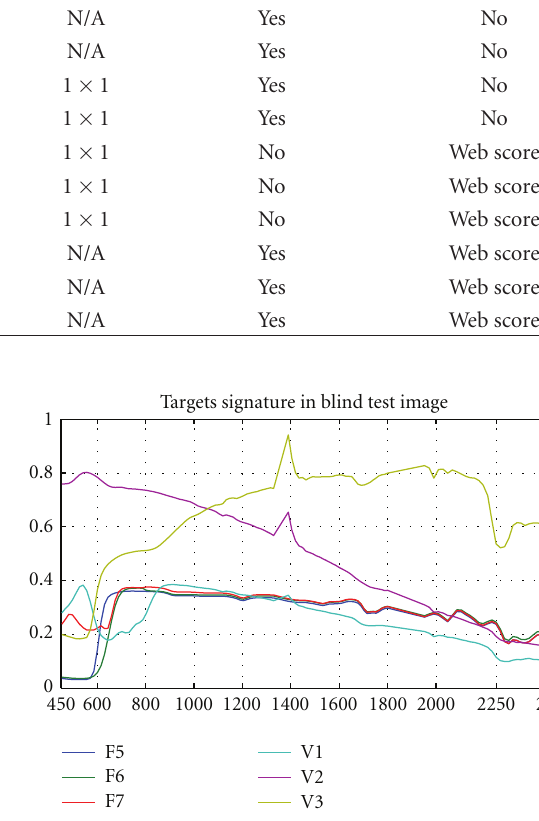
Figure 3: Spectral signatures of the targets that are present in the Blind test image x -axis is the wavelength [nm] and y -axis is the reflectance unit